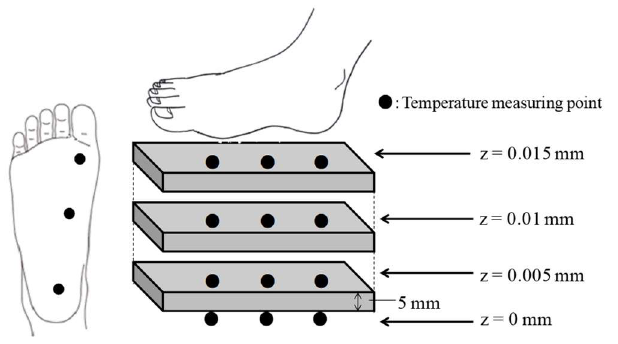
Figure 2. Conceptual diagram of temperature measurement